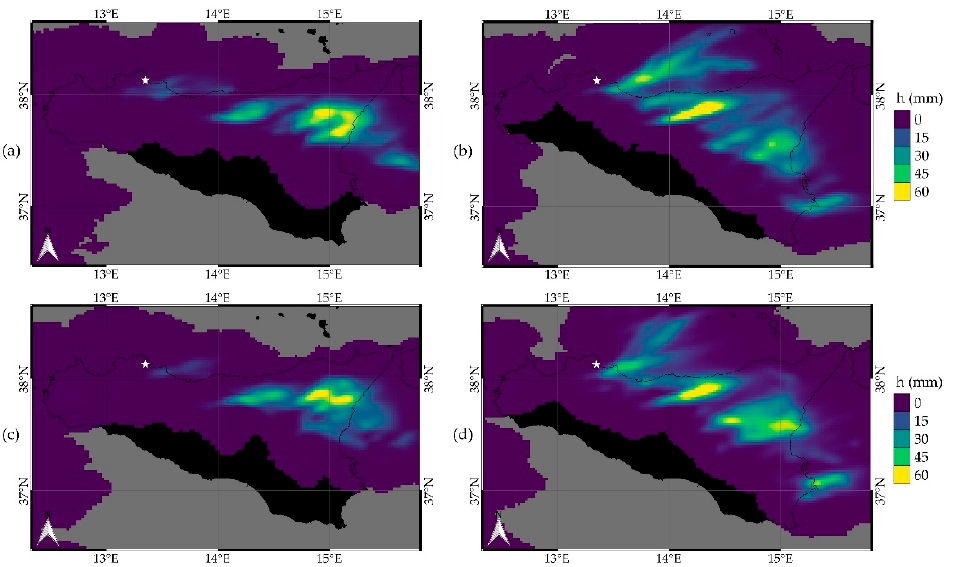
Figure 8. The map shows the rainfall depth at 2.5 km resolution forecasted from 12 to 16 UTC by the WRF model experiment of the 15 July 12:00 UTC using: for ( a ) only the weather radar data assimilation, for ( b ) weather radar data and hygrometers, for ( c ) weather radar data and anemometers and for ( d ) weather radar data, anemometer, hygrometers and thermometers.